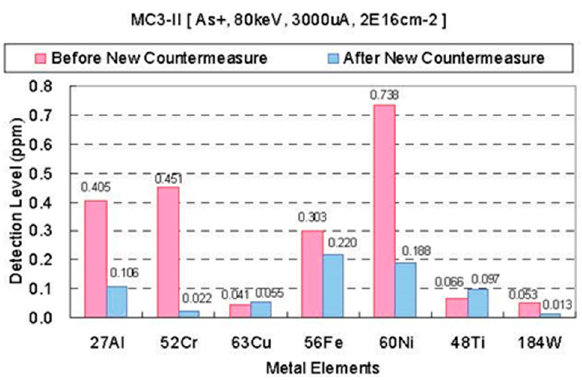
Figure 5. Metal contamination measurement by inductively coupled plasma mass spectrometry (ICPMS) [17]. Red denotes the metal contamination before the new countermeasure, and blue denotes that after the new countermeasure, in a MC3-II of SMIT.